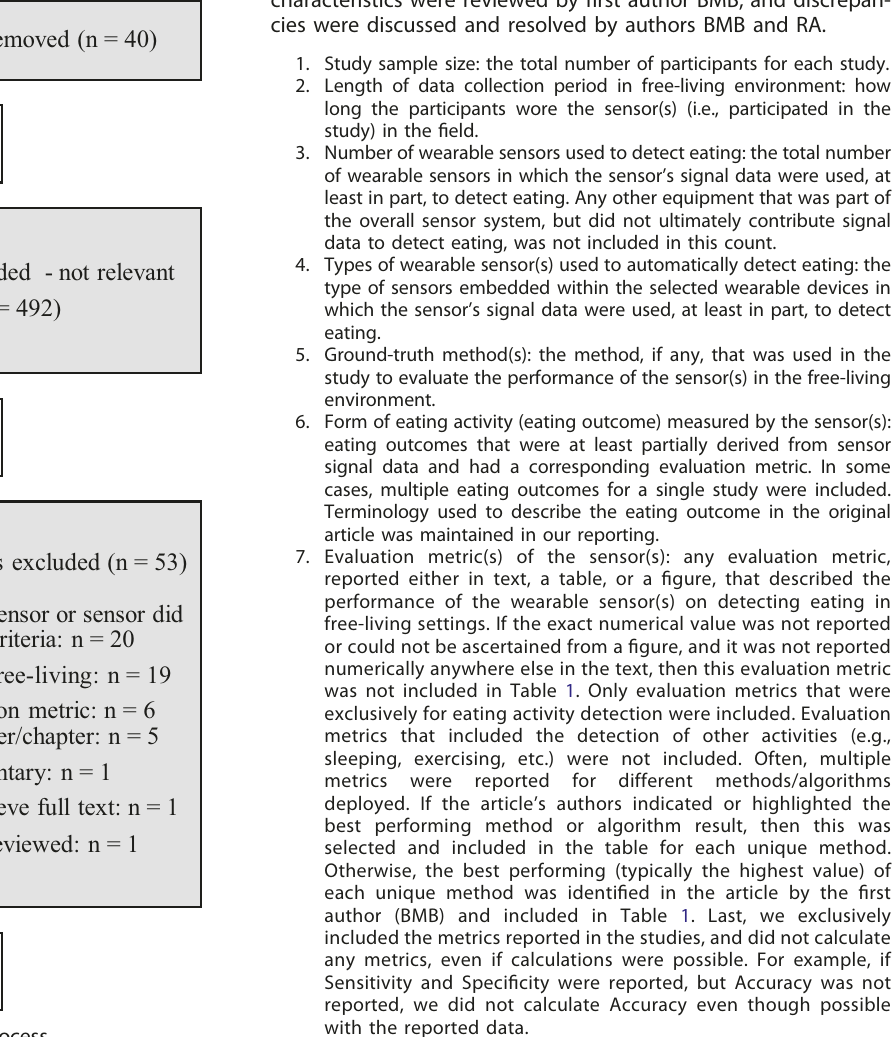
Fig. 1 Flow diagram of article selection